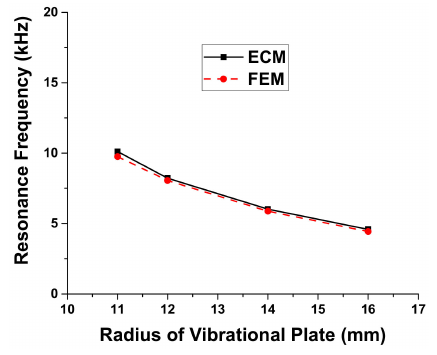
Figure 5. Effect of the vibrational plate radius variation on resonance the frequency.